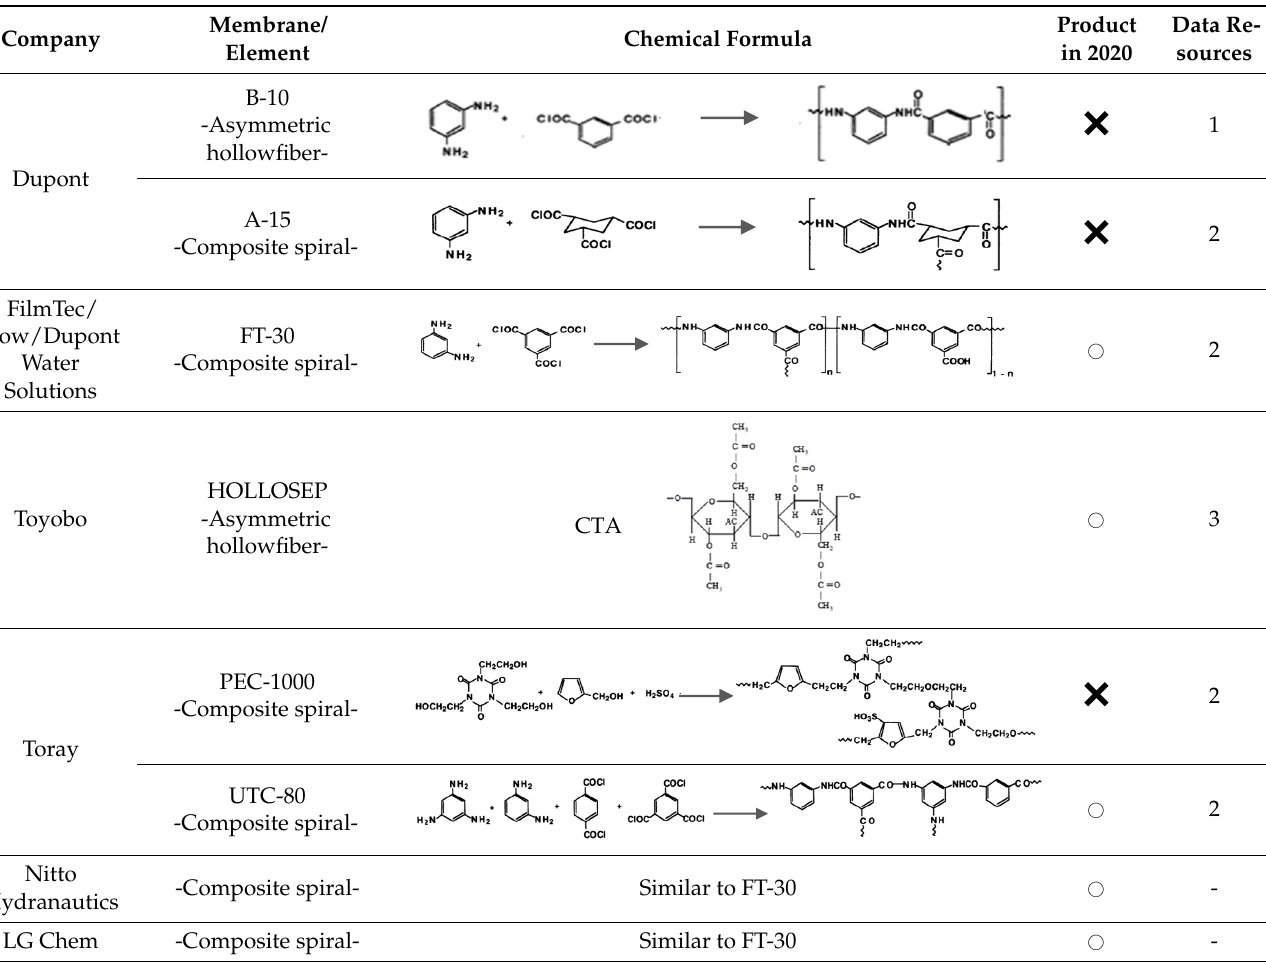
Table 1. Commercial SWRO membrane material and configuration.